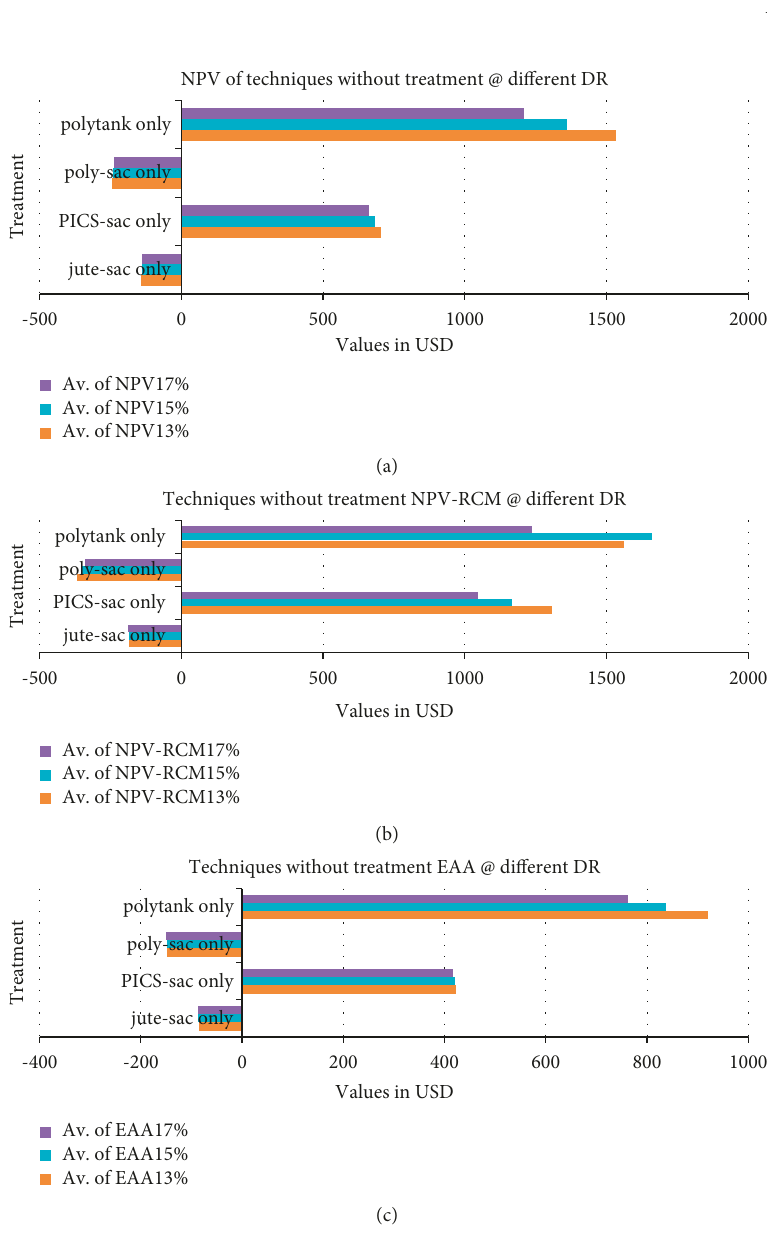
Figure 9: Techniques without treatment NPV, NPV-RCM, and EAA at different